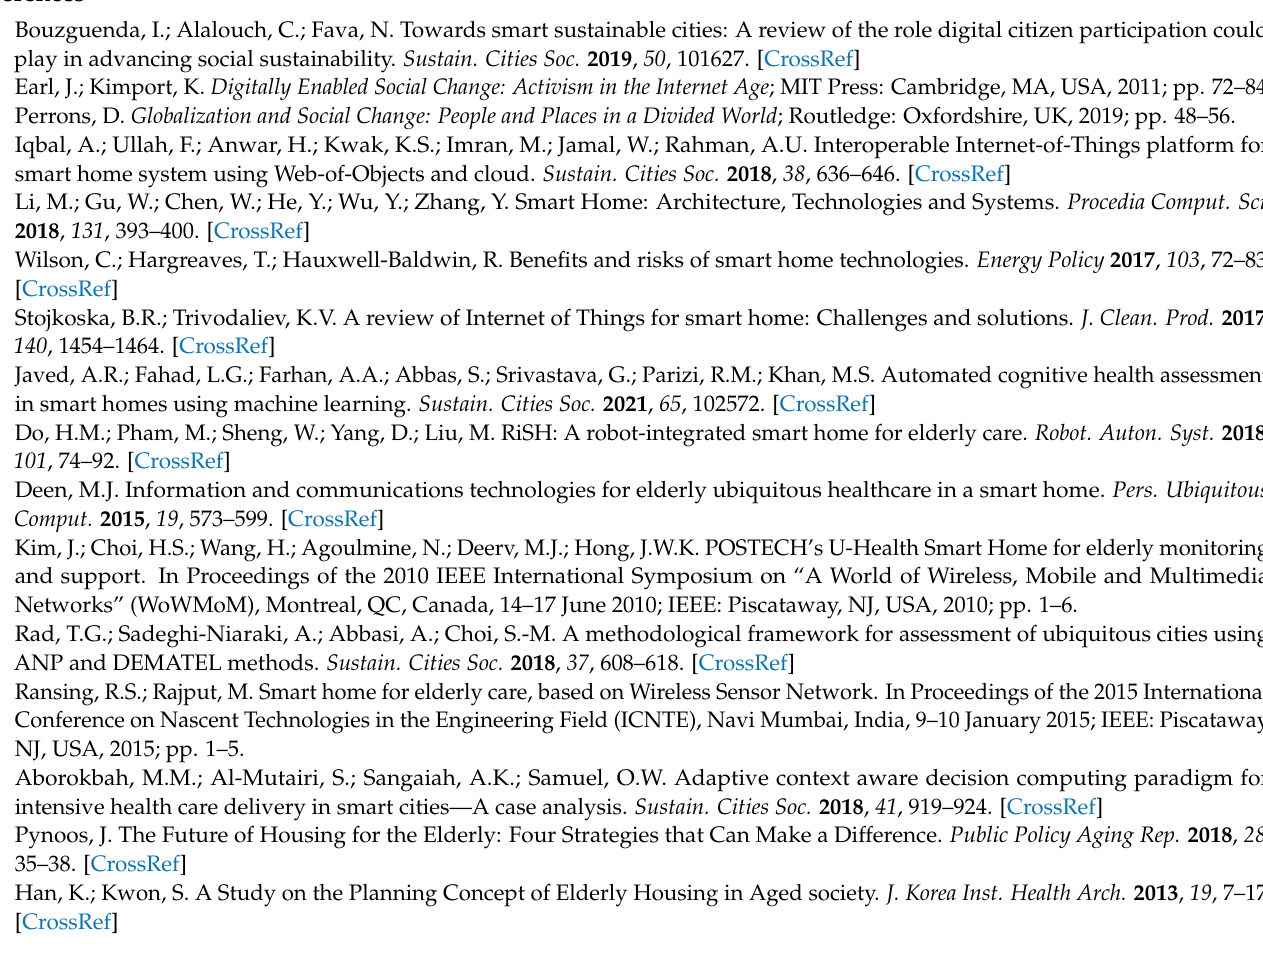
Figure A1. Smart Home Technology Acceptance and Preference Survey.